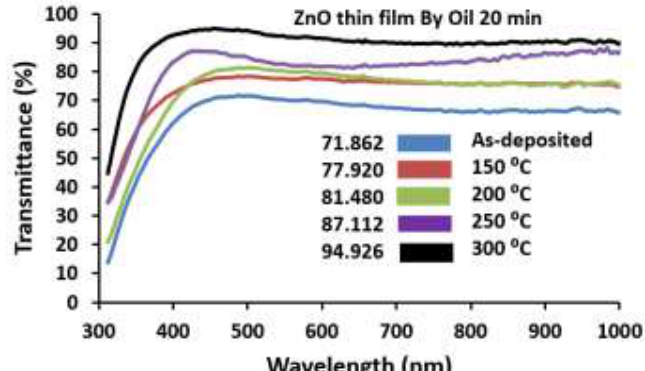
Figure 8: shows the Transmittance curve of ZnO film before and after annealing by OTA technique at 150 °C, 200 °C, 250 °C, and 300